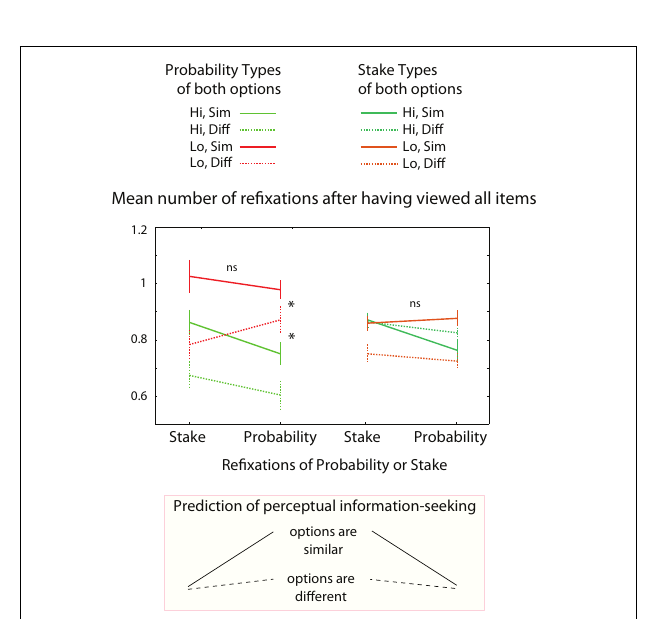
FIGURE 12 | Information about number identity or option EV ? When probabilities are similar, or stakes are similar, the decision is harder because more precise information is required to distinguish the options. Accordingly participants make more acquisitions by refixating. However, if the probabilities are similar, we do not find increased refixations specifically of probabilities; likewise when stakes are similar, we do not see increased refixations specifically of stakes. This suggests that the representational level that directs attention is not a perceptual or numerical level, but